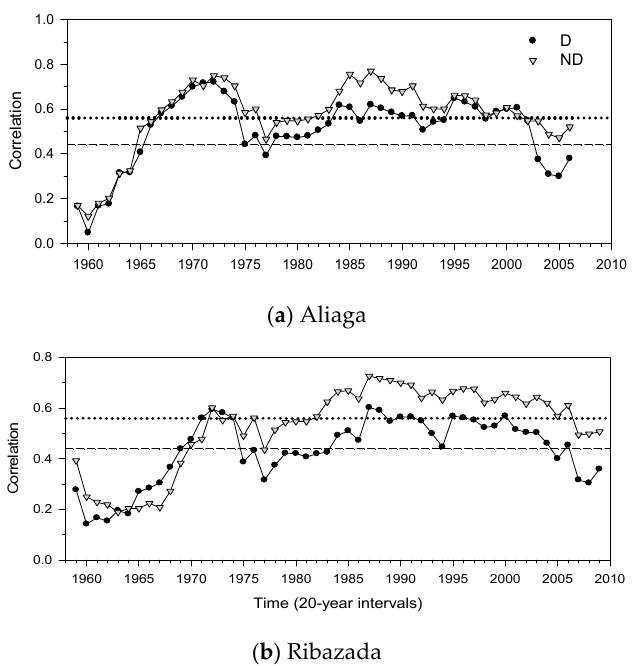
Figure 6. Moving climate-growth Pearson correlations calculated between series of ring-width indices of declining (D) and non-declining (ND) junipers vs. summer precipitation considering 20-year intervals. The correlation values are plotted for the 10th correlation of each 20-year interval (e.g., the correlation value plotted in 1959 corresponds to the 1950–1969 interval). Dashed and dotted horizontal lines show the 0.05 and 0.01 significance levels, respectively.